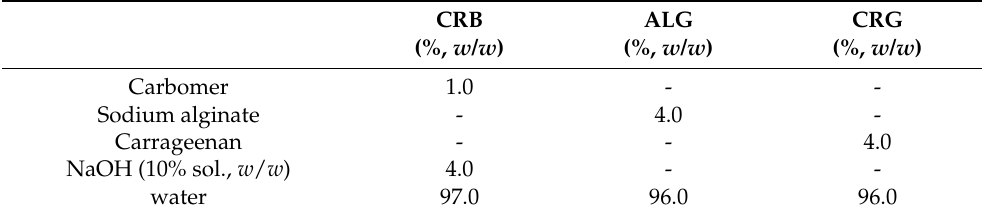
Table 6. The Composition of the Gels; Carbomer (CRB), Sodium Alginate (ALG), and Carrageenan (CRG). CRB ALG CRG (%, w / w ) (%, w / w ) (%, w / w ) Carbomer 1.0 - - Sodium alginate - 4.0 - Carrageenan - - 4.0 NaOH (10% sol., w / w ) 4.0 - - water 97.0 96.0